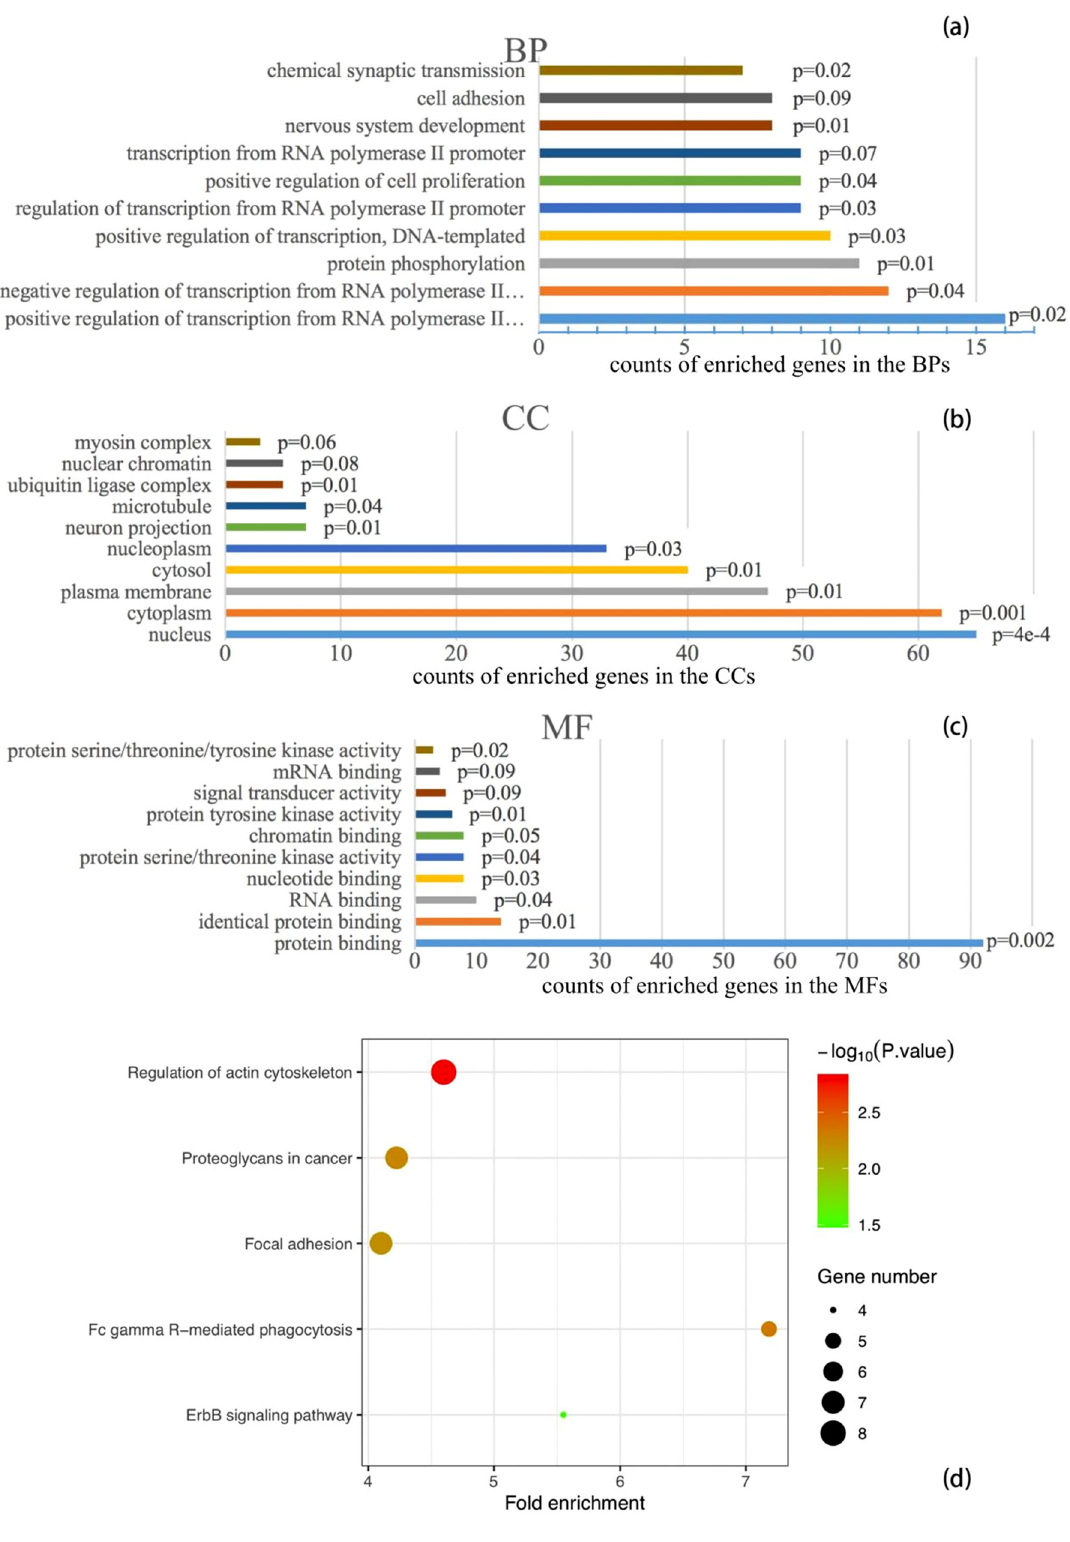
Figure 2: Top 10 gene counts of enrichment in BPs ( a ) , CCs ( b ) , and MFs ( c ) , and KEGG pathways ( d ) . Note: bar colors in ( a ) , ( b ) , and ( c ) only represent intuitive distinguishing of entries, not any scale of